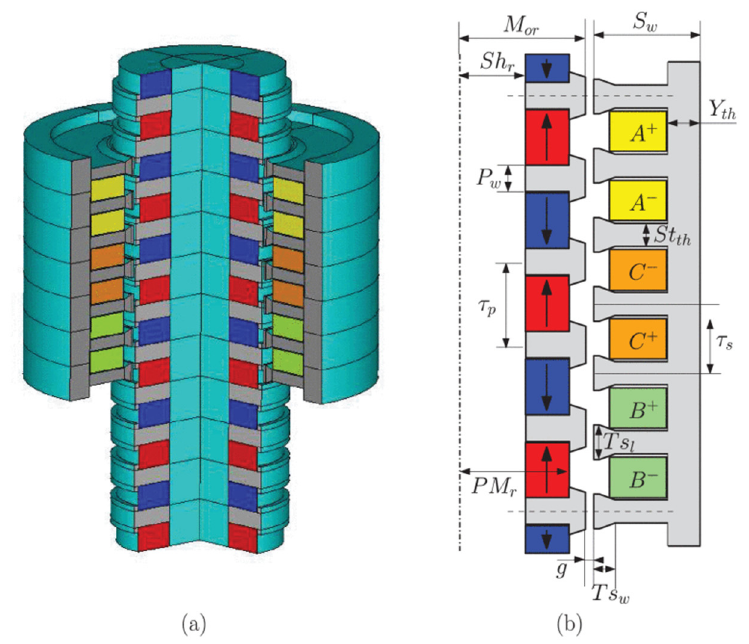
Figure 1. Structure of the PMLM with slotted iron core: ( a ) 3D view; ( b ) Plan view.